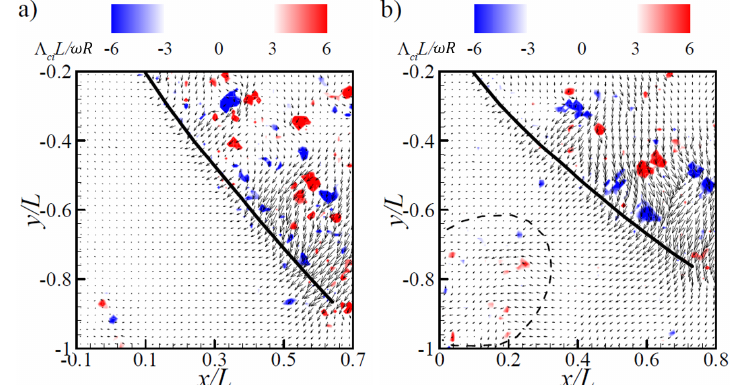
Figure 14. Snapshots of velocity fields with superimposed swirling strength (normalized by L / ω R ) around the thick plate under: ( a ) ω = 60 rpm; and ( b ) ω = 90